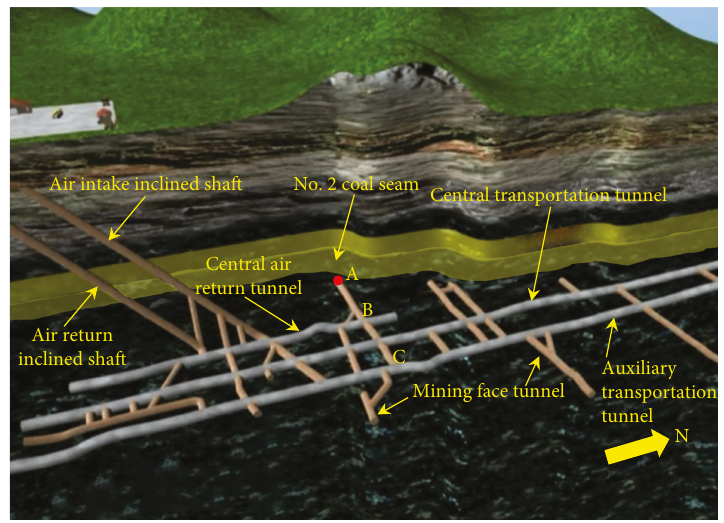
Figure 4: Distribution of tunnels at the Diezigou mining